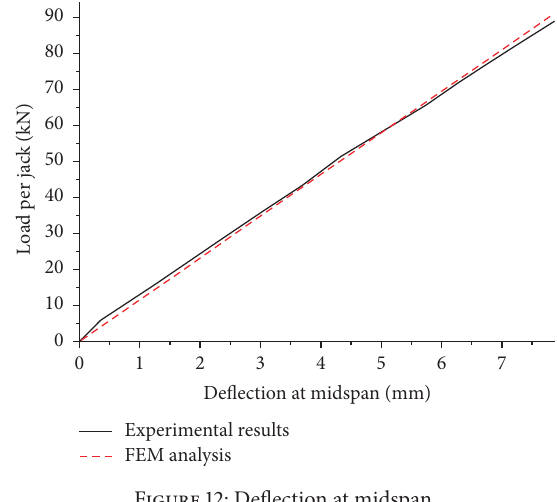
Figure 12: Deflection at